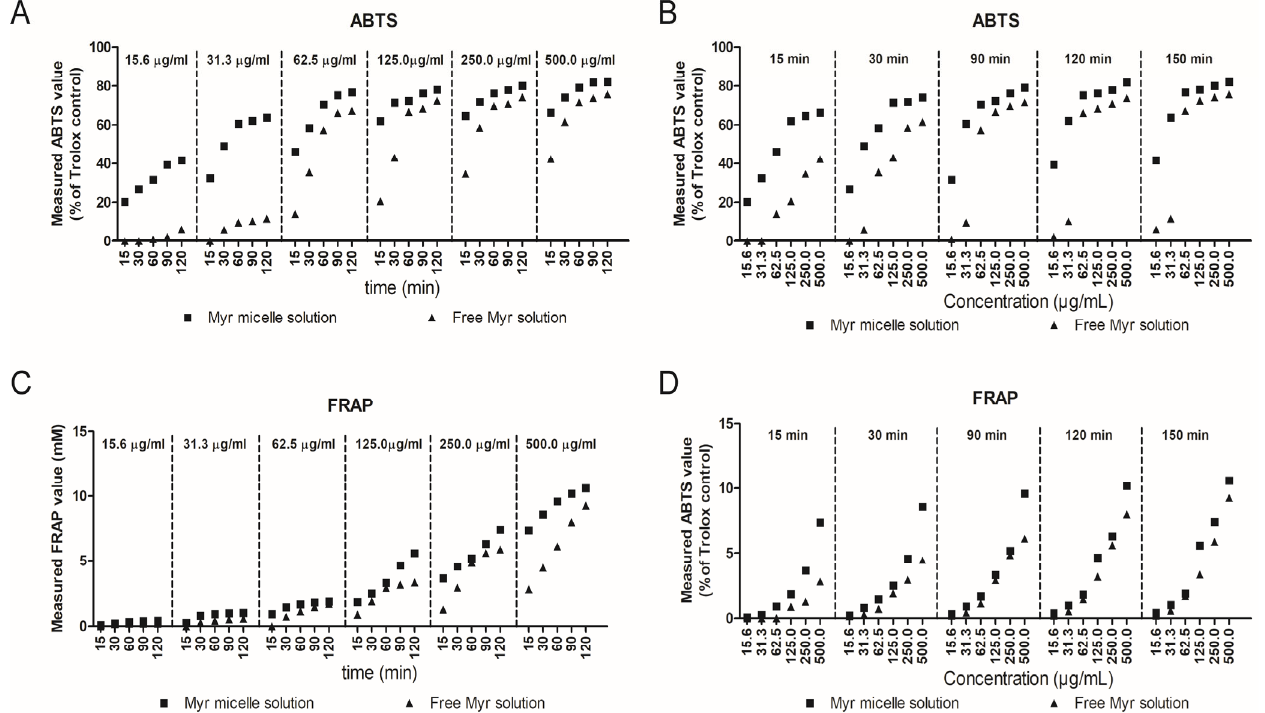
Figure 7. Measured antioxidant characterizations using 2,2 (cid:48) -Azinobis (3-ethylbenzothiazoline 6- sulfonate) (ABTS) free-radical scavenging assay. Measured ABTS values of the free myricetin and myricetin micelles with different incubation times as functions of concentration ( A ) and different concentrations as functions of time ( B ); Measured FRAP values of the free myricetin and myricetin micelles with different incubation times as functions of concentration ( C ) and different concentrations as functions of time ( D ). Reproduced with permission from Sun et al. [219].